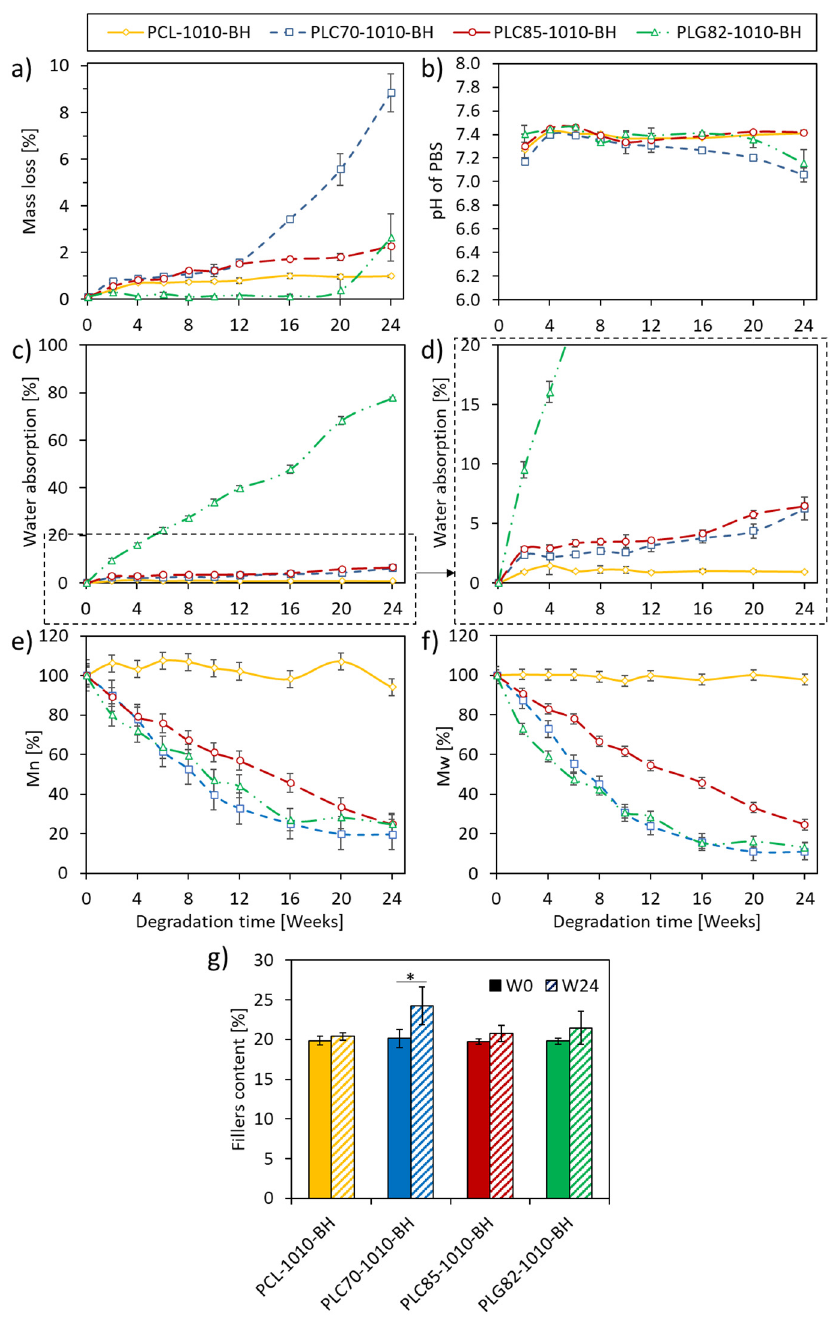
Figure 2. Results from degradation experiment of composites: ( a ) the mass loss, ( b ) pH of PBS, ( c , d ) the water absorption, ( e ) the relative M n , ( f ) the relative M w , ( g ) the content of fillers in the matrix measured by TGA. *—when p < 0.05.